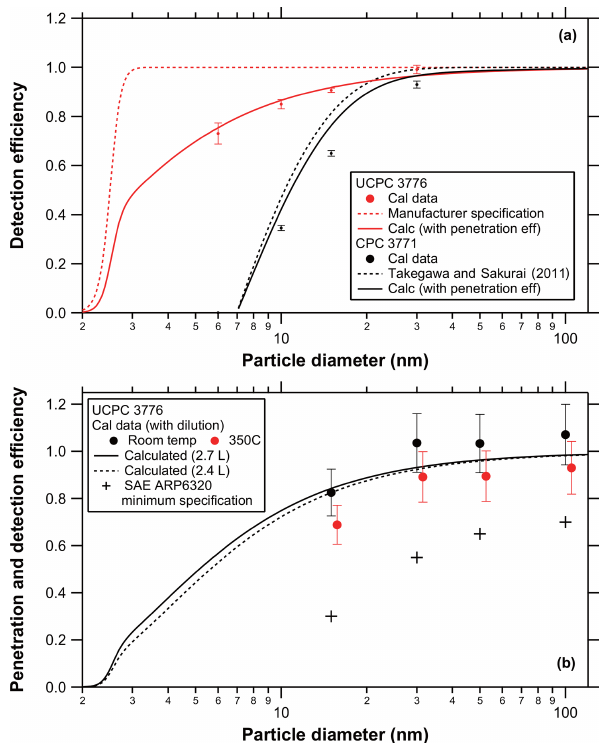
Figure 3. Laboratory evaluation of the performance of the UCPC and CPC. (a) Size-resolved detection efficiencies of the UCPC (red circles) and CPC (black circles) measured in the laboratory. The curves represent the empirically calculated detection and penetra- tion efficiency curves for the UCPC and CPC: the detection effi- ciency of the UCPC (red dashed line); the detection efficiency of the UCPC incorporating the penetration efficiencies in the UCPC internal and sampling tube (red solid line); the detection efficiency of the CPC (black dashed line); and the detection efficiency of the CPC incorporating the penetration efficiency through the sampling tube (black solid line). See Sect. S1 for details on the definition. (b) Penetration and detection efficiency of non-volatile propane soot particles through the heater section measured at room temperature ( ∼ 19–21 ◦ C; black circles) and at 350 ◦ C (red circles). The calcu- lated curves include the penetration efficiency through the heater section and the detection efficiency of the UCPC at 20 ◦ C with the flow rate through the heater at 2.7 (solid) and 2.4 (dashed) Lmin − 1 . The penetration efficiency curve at 350 ◦ C (not shown) was deter- mined by scaling the calculated curve at 20 ◦ C with the experimen- tal values at 350 ◦ C and room temperature for larger diameters (30, 50, and 100nm). The cross symbols represent the minimum pen- etration efficiency of non-volatile particles specified by the SAE- ARP6320